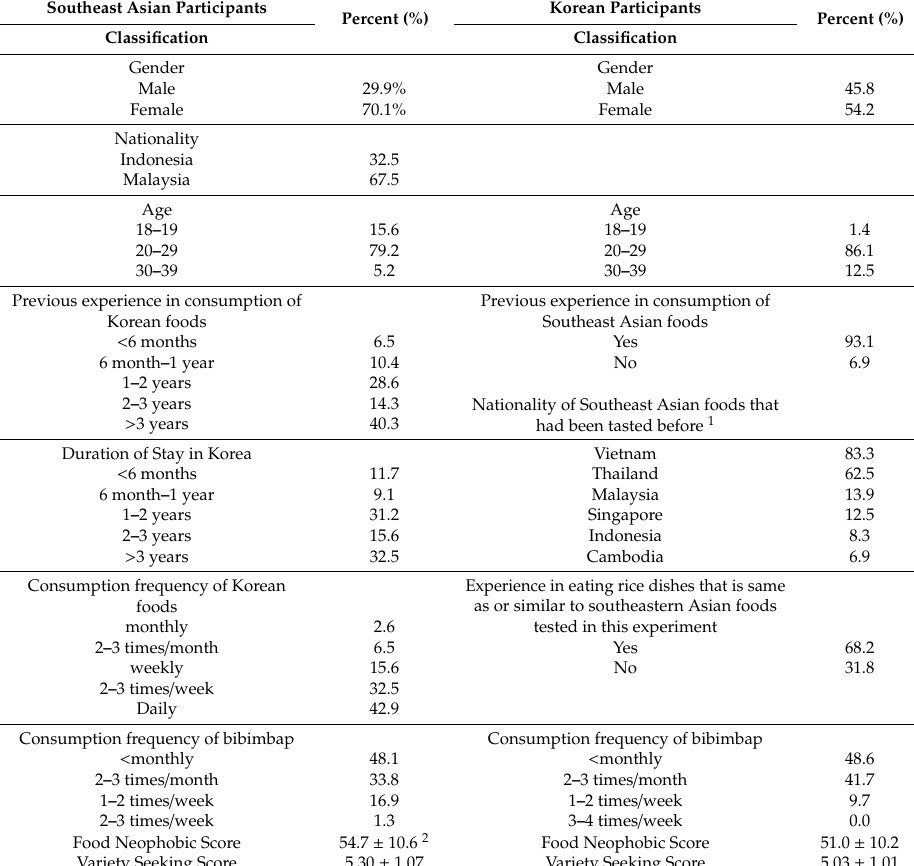
Table 2. Participants’ demographics and ethnic foods consumption